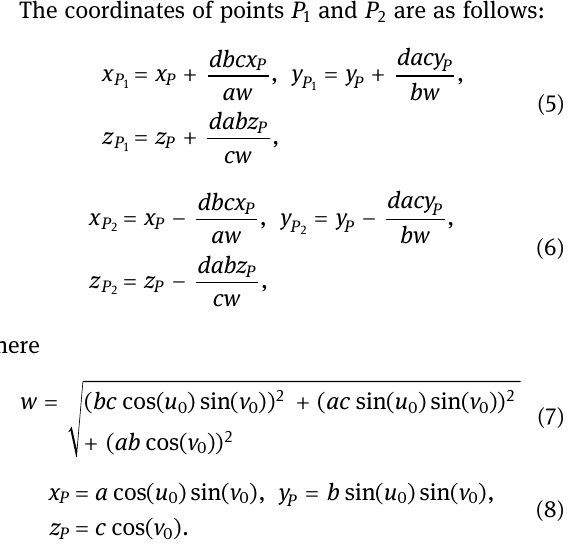
plane. To get the coordinates x 0 P